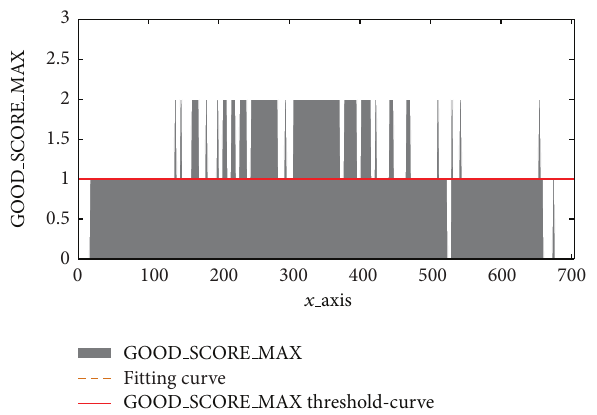
Figure 20: GOOD SCORE MAX threshold-curve figure (see (11)).